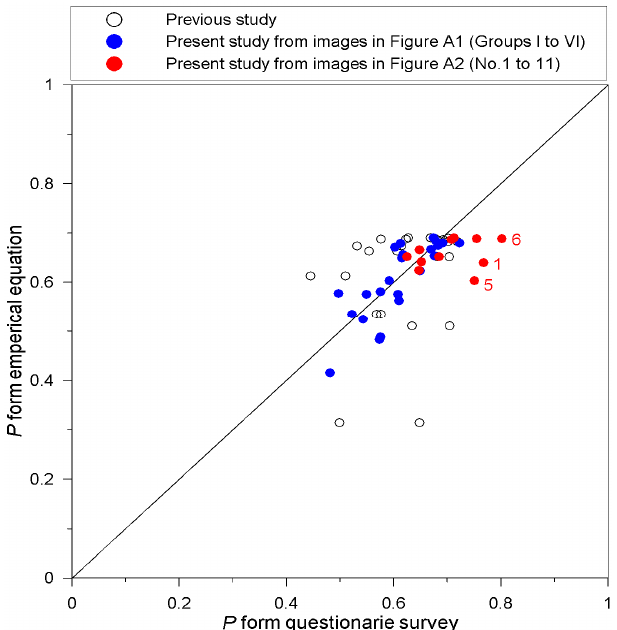
Figure 12. Relationship between the visual preference P from the empirical Equation (9) and P from the questionnaire survey. Data from the present study of a third-order urban stream and published results [29] for first- to second-order mountain streams. Images 5 and 6 have a high degree of artificial facilities ( I R + B R > 20%), while image 1 has less human intervention and is closer to its natural state.